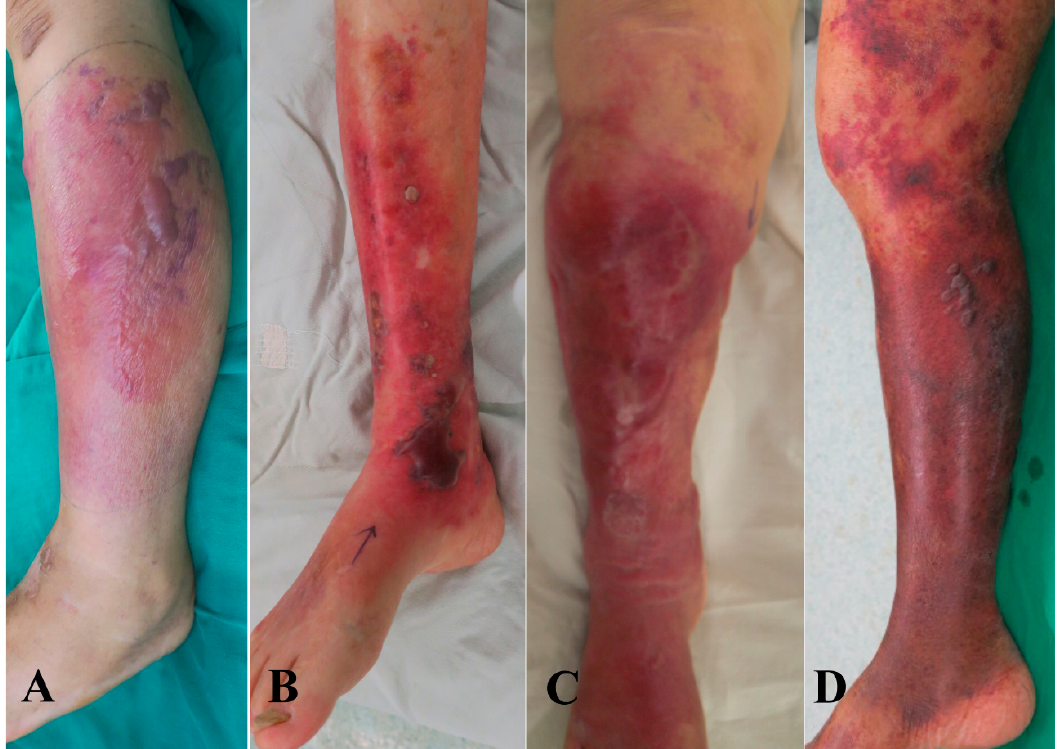
Figure 2. Skin lesions in patients with Gram-negative necrotizing fasciitis. ( A ) A 75 year-old patient with Vibrio vulnificus infection revealed to have hemorrhagic bullae lesions on left leg. ( B ) A 86 year-old male with Aeromonas hydrophila in wound culture of left leg revealed to have hemorrhagic bullae lesions. ( C ) A 81 year-old female with Serratia marcescens infection presented with lower right leg hemorrhagic bullae lesions. ( D ) A 78 year-old male with Aeromonas sobria infection in blood and wound cultures revealed to have lower right leg hemorrhagic bullae lesions.